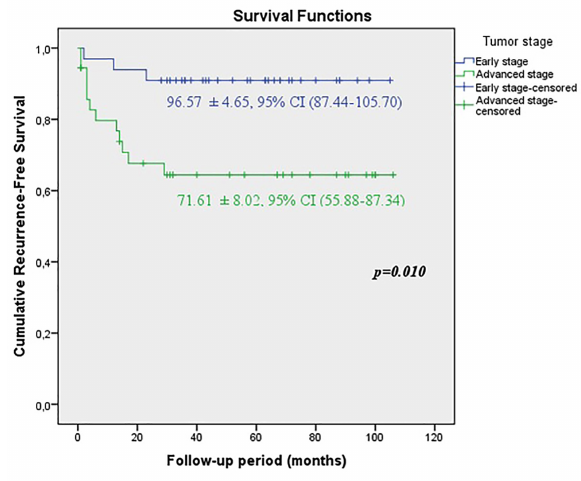
Figure 1A - KKaplan-Meier plots of recurrence-free survival according to the early and advanced stages for all tumors.